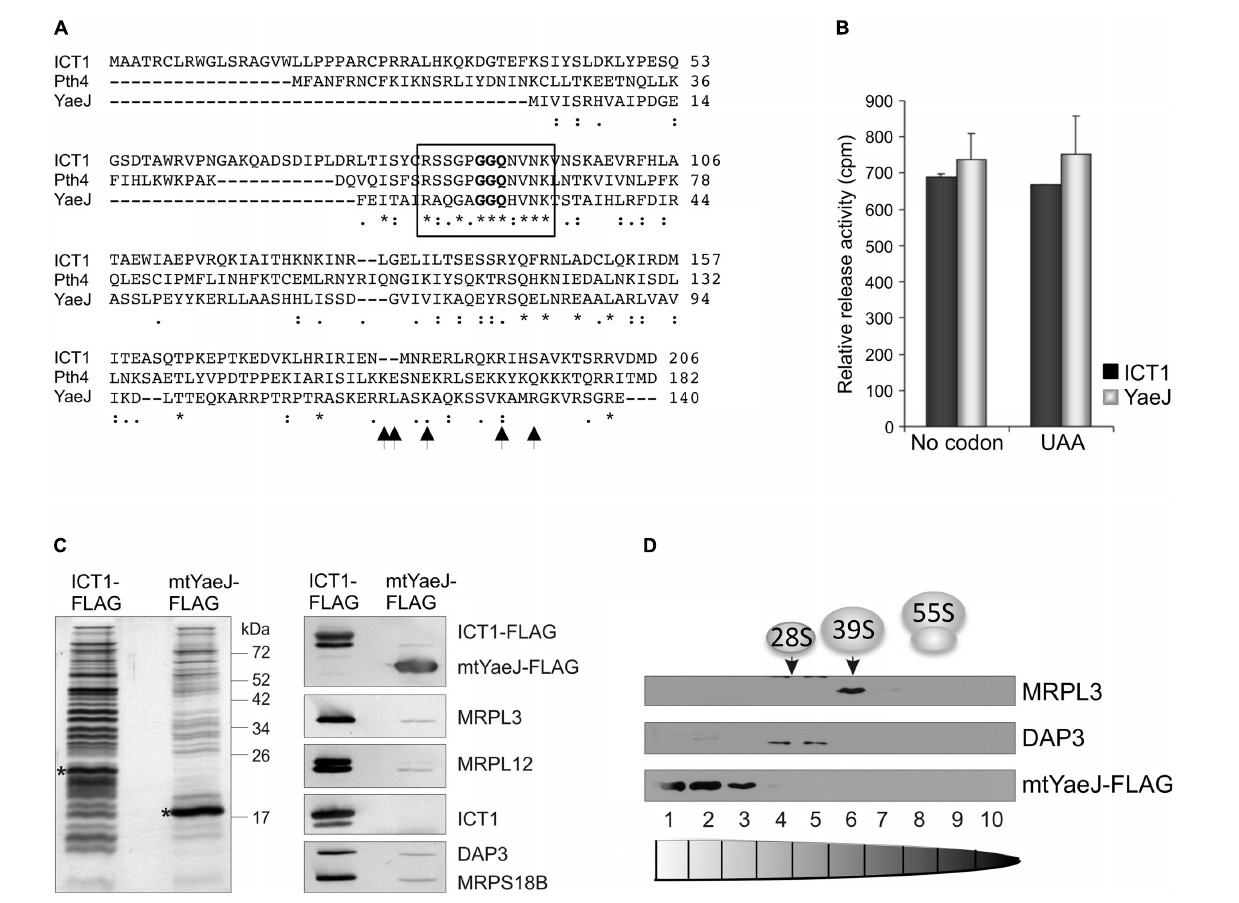
FIGURE 1 | ICT1 as a mitochondrial translation rescue factor and its possible orthologs. (A) Alignment of human ICT1 (14197) with the Pth4 ortholog from S. pombe (Q9HDZ3) and YaeJ ortholog from E. coli (E2QFB9). Identity is indicated by (*), high levels of similarity by (:) and lower levels by ( · ). The conserved GGQ region is boxed and the YaeJ residues that are required for PTH activity and are highly conserved between bacterial species are indicated by arrows. (B) Release activity of recombinant YaeJ and ICT1. PTH activity was tested on 70S ribosomes primed with either no RNA or UAA triplet in the A-site. (C) Mitochondrial targetted YaeJ-FLAG shows interaction with human mitochondrial ribosomal proteins . FLAG tag mediated immunoprecipitations of ICT1 and mitochondrially targeted YaeJ were performed on lysates of HEK293 cell lines induced for 3 days. The elution fractions (10%) were separated by SDS PAGE and analyzed by silver